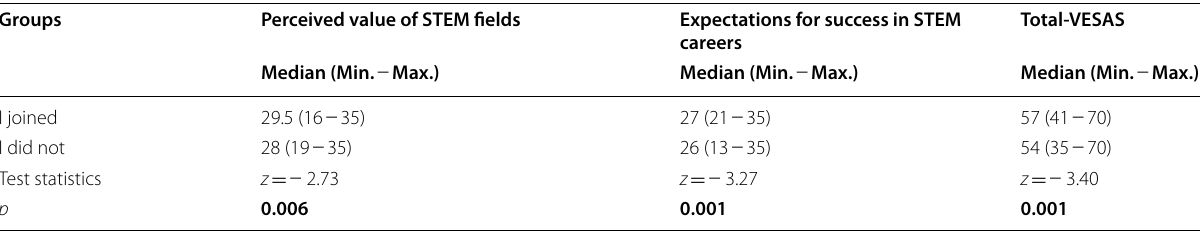
Table 8 The results of Mann Whitney U test for participants’ STEM motivation scores according to the variable of ‘having participated in STEM activities’ Groups